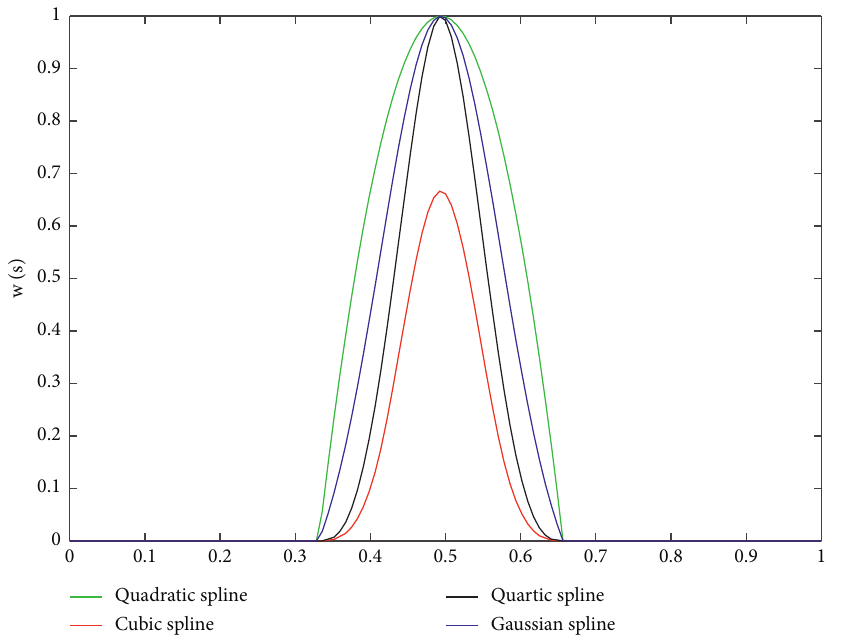
Figure 2: Shapes of different weight functions for x